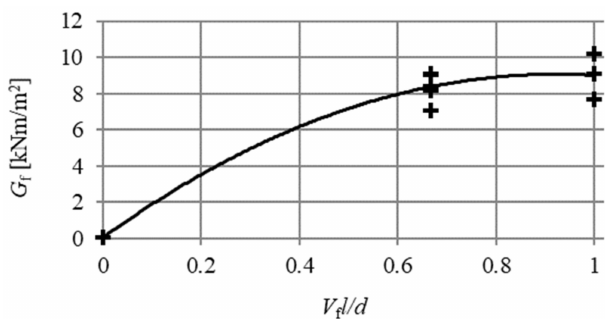
Figure 15. HSC and SFRHSC beams’ fracture energy results (G f ) depending on fibre reinforcement ratio (V f l / d) and polynomial regression Equation (7).